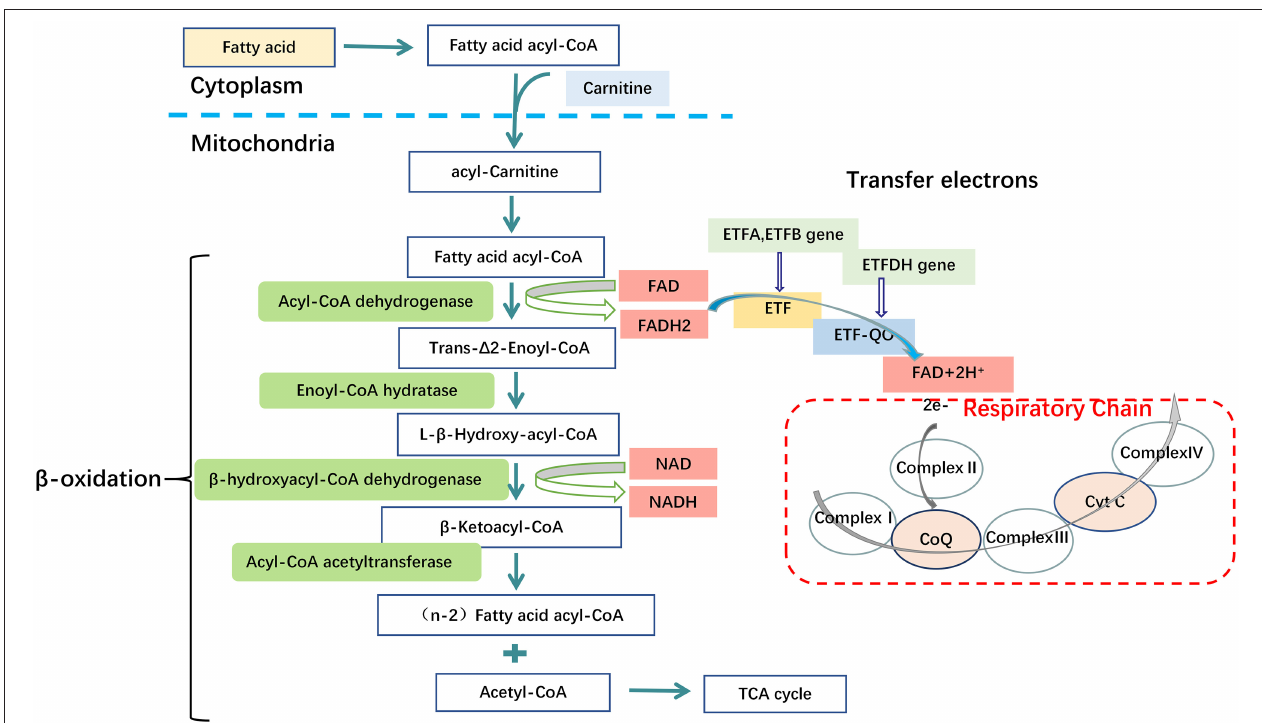
FIGURE 3 | Metabolic disorders of fatty acid in GA-II. Mutations in the Electron Transfer Flavoprotein (ETFA, ETFB) or Electron Transfer Flavoprotein Dehydrogenase (ETFDH) genes. These genes encode the α / β subunits of Electron Transfer Flavoprotein (ETF) and Electron Transfer Flavoprotein-Ubiquinone Oxidoreductase (ETF-QO) respectively. ETF and ETF-QO are the key transporters in the process of electron transfer of fatty acid β -oxidation. In mitochondria, ETF, which is located in the matrix, receives electrons from several FAD-containing acyl-CoA dehydrogenases involved in fatty acid oxidation. ETF transfers electrons to ETF-QO, located in the inner mitochondrial membrane and, subsequently, electrons are passed to ubiquinone in the respiratory chain. Consequently, a dysfunction of ETF or ETF-QO causes the final process of fatty acid β -oxidation to fail, thereby leading to disturbed ATP biosynthesis from fatty acid, excessive lipid accumulation and disturbed gluconeogenesis, Complex I (NADH: ubiquinone reductase), complex II (succinate: ubiquinone reductase), complex III (ubiquinol: cytochrome C oxidoreductase or cytochrome bc1 complex), complex IV (cytochrome c